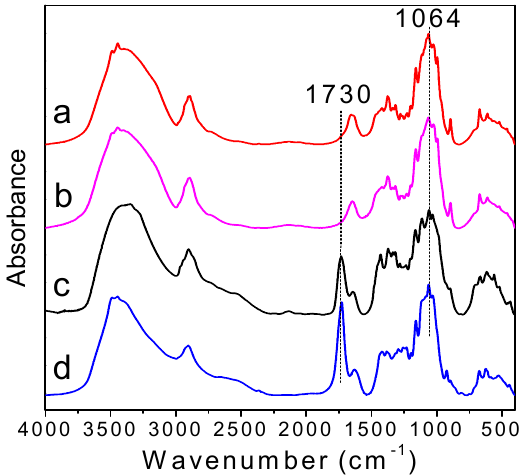
Figure 2. FTIR spectrum of (a) pristine cellulose; (b) NaOH/urea-treated cellulose; (c) direct TEMPO-oxidized cellulose; and (d) NaOH/urea-treated TEMPO-oxidized cellulose.